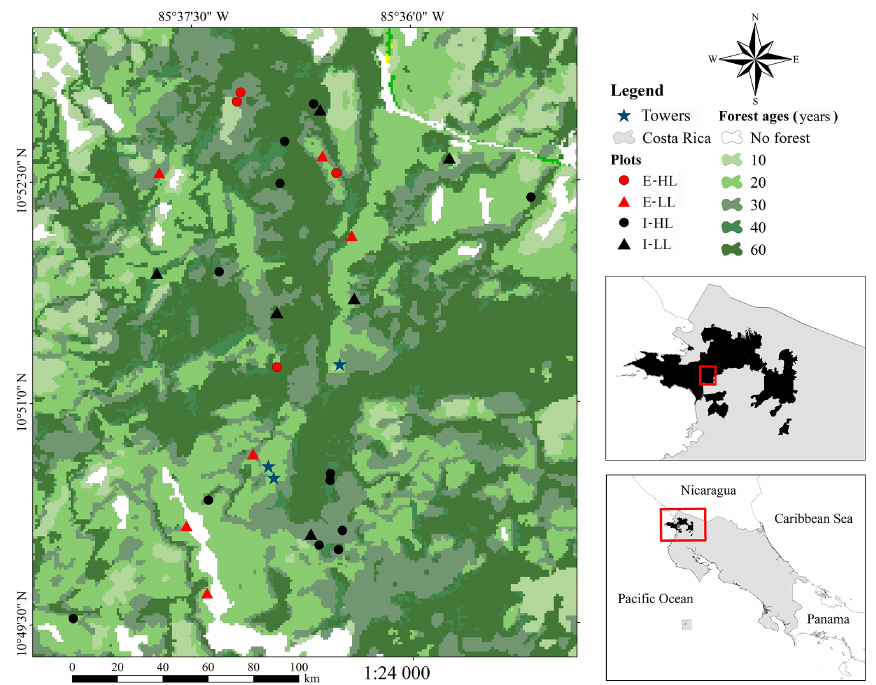
Figure 1. Location of the sampled forest plots at the Santa Rosa National Park Environmental Monitoring Super Site in Guanacaste, Costa Rica. E-HL indicates early successional stage with a high relative abundance of lianas; E-LL indicates early successional stage with a low relative abundance of lianas; I-HL indicates intermediate successional stage with a high relative abundance of lianas; I-LL indicates intermediate successional stage with a low relative abundance of lianas. Forest ages refer to 60 forests detected since 1956; 40 forests detected since 1979; 30 forests detected since 1986; 20 forests detected since 1997; 10 forests detected since 2005; and no forest, corresponding to non-related to